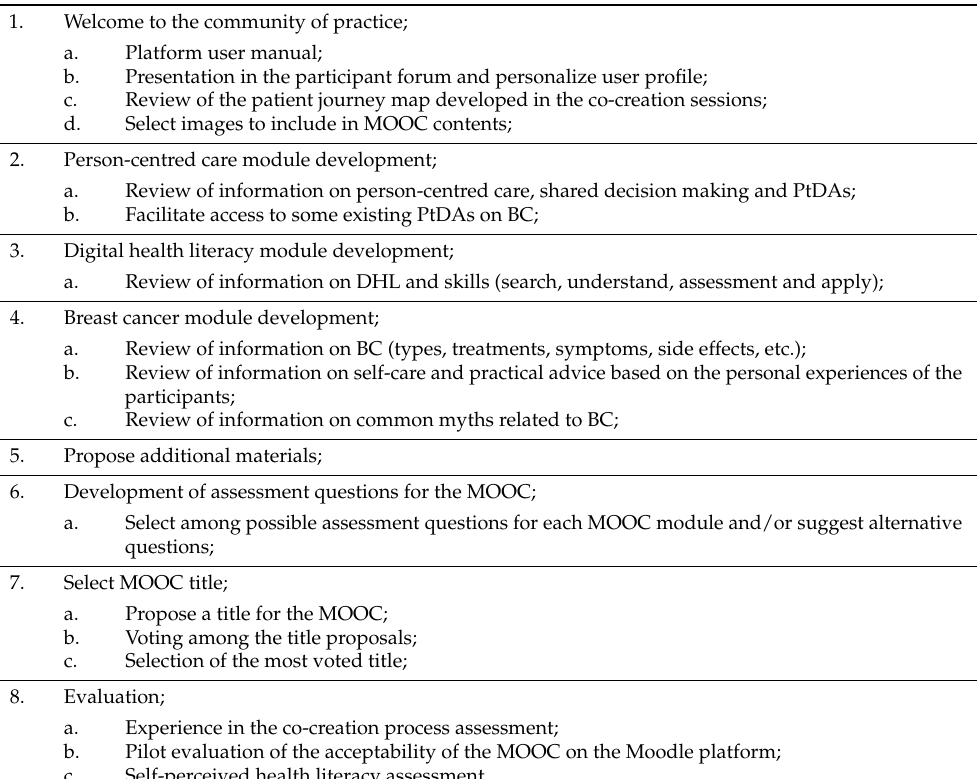
Table 2. Co-creation activities online in Moodle platform (development